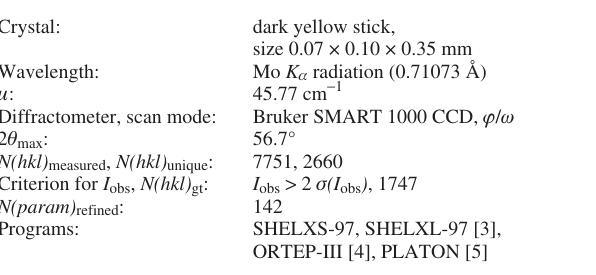
Table 1. Data collection and